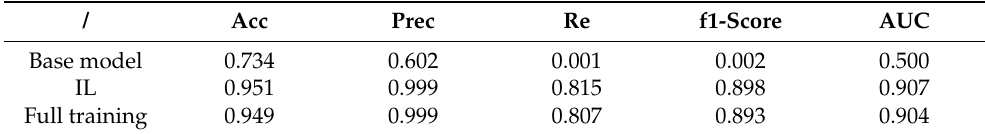
Table 5. Evaluation Indicators of Three Models.